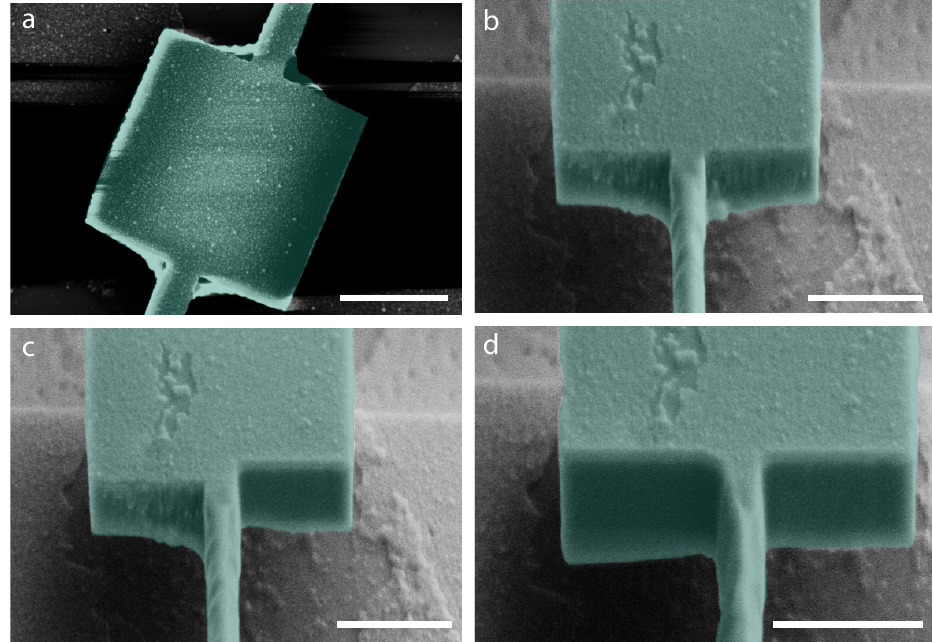
Figure 5. Cleaning steps of the device (B9) using a FIB. ( a ) Anchored unclean device ( b ); side view of partially cleaned device. The torsional rod is cleaned in this step. ( c ) Cleaning one edge by cutting the paddle by 100 nm. ( d ) Cleaned device from both sides. All scale bars are 1.2 µ m.